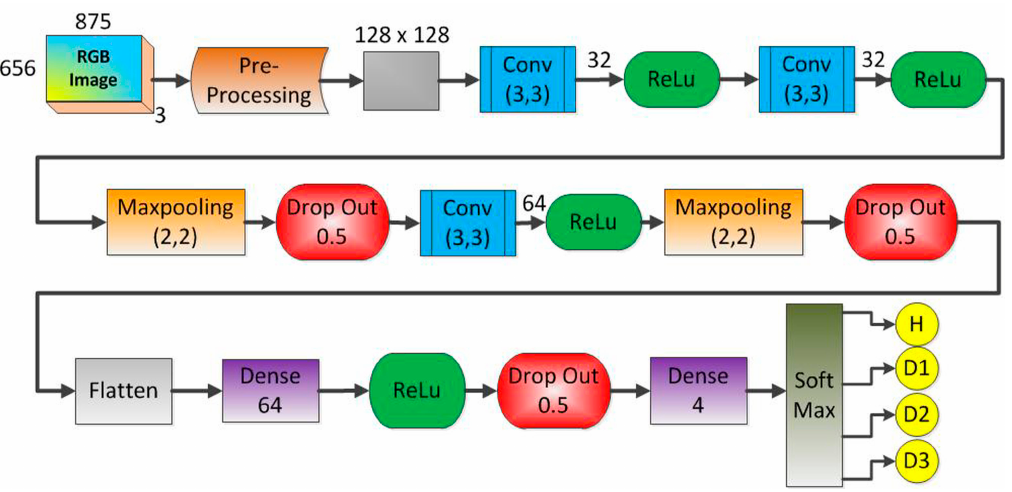
Figure 9. Architecture of the developed CNN to identify structural damage.